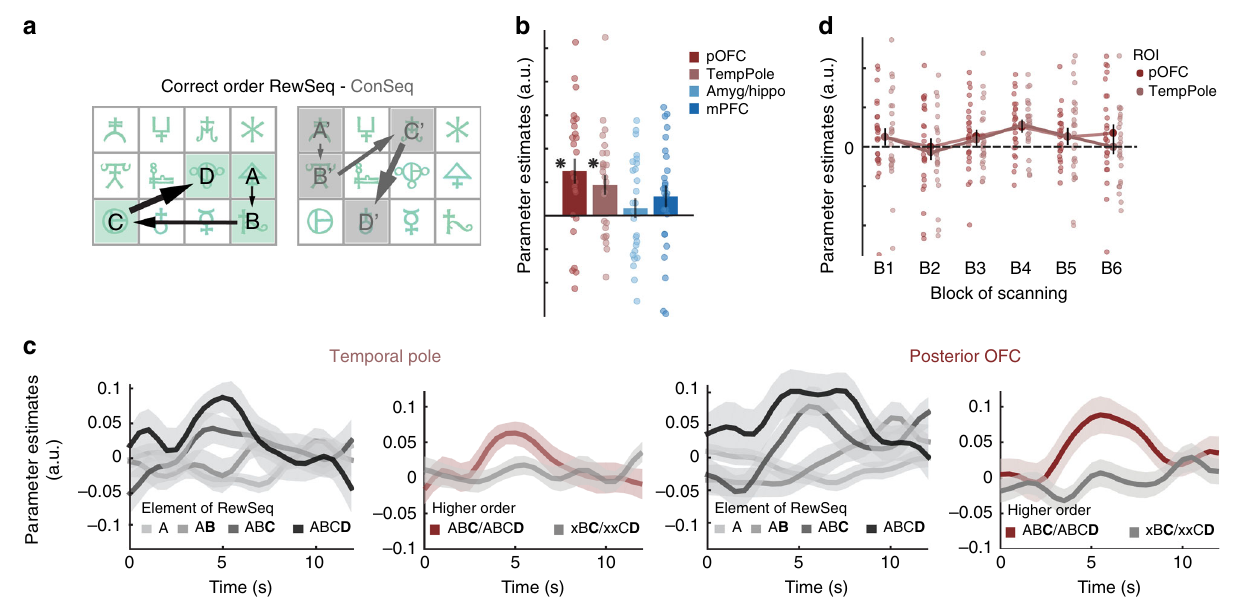
Fig. 3 Correct sequence order (path to reward) in temporal pole and pOFC. a The encoding of correctly ordered sequence associations were examined using occurrences of B after A, C after AB, and D after ABC, and by contrasting RewSeq and ConSeq. In other words, this contrast probed RL-acquired directed higher-order stimulus – stimulus associations. b pOFC and tempPole, but not mPFC and amyg/hippo, showed stronger BOLD responses for correct sequence order for RewSeq vs ConSeq and thus tracked the path to reward learnt pre-scanning; * p < 0.05 in one-sample t -test. c Illustration of the effects: (Left) The average time-series to A, (A)B, (AB)C, and (ABC)D illustrate an increase in BOLD activation as participants progress through the correctly ordered associations. (Right) Higher-order associations were necessary for driving the BOLD signal: BOLD average for C and D elements when higher- order conditioned chains were respected (red; average of ABC or ABCD, bold highlights indicate time-locking) compared to when only the pair-structure was ful fi lled (average of xBC, xxCD; gray). d The BOLD representation of correct sequence order was robust and did not change over scan blocks despite being irrelevant for the task performed during scanning. Error bars denote SE; see also Supplementary Fig.